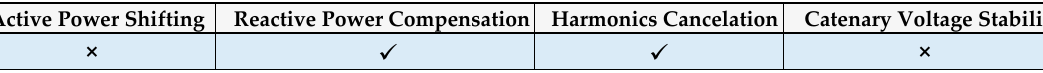
Figure 3. RPC operating in SVC mode (RPC based SVC) (based on [40]).